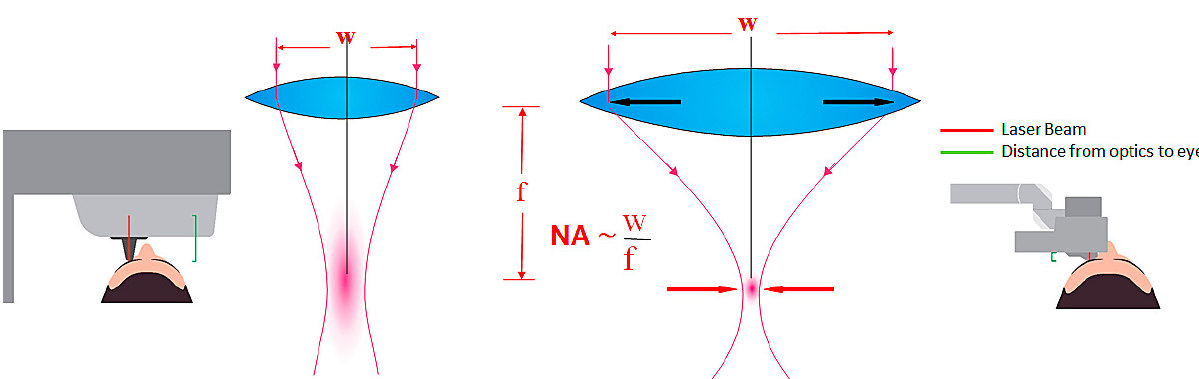
Figure 2. Middle: At a given working distance, increase of NA requires larger focusing optics. At large working distance (system to the left) the NA is limited to about 0.3. Substantial reduction of working distance (system to the right) allows for further increase of the numerical aperture, while shrinking the optics at the same time at the cost of scanning the focusing optics. The numerical aperture (NA) is defined as the quotient of W (optics diameter) and focal length (f). In this sense, with a smaller NA of, for example, 0.2 and an energy of ~1.35 μ J at 150